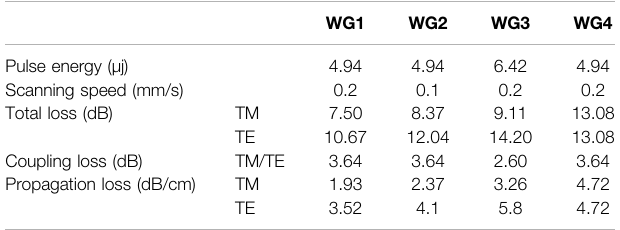
TABLE 1 | Processing parameters and the losses of the